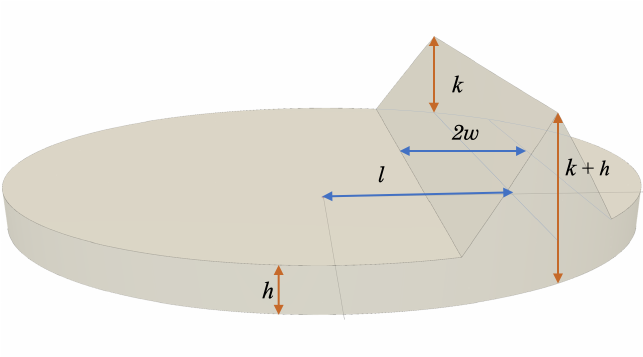
Figure 3. Graphical representation of a continuous streak signal (modeled as a wedge using Equation (44)) within the unit circle, including background intensity h , peak intensity of streak k , width of the streak w , and distance from the origin to the streak (cid:96)